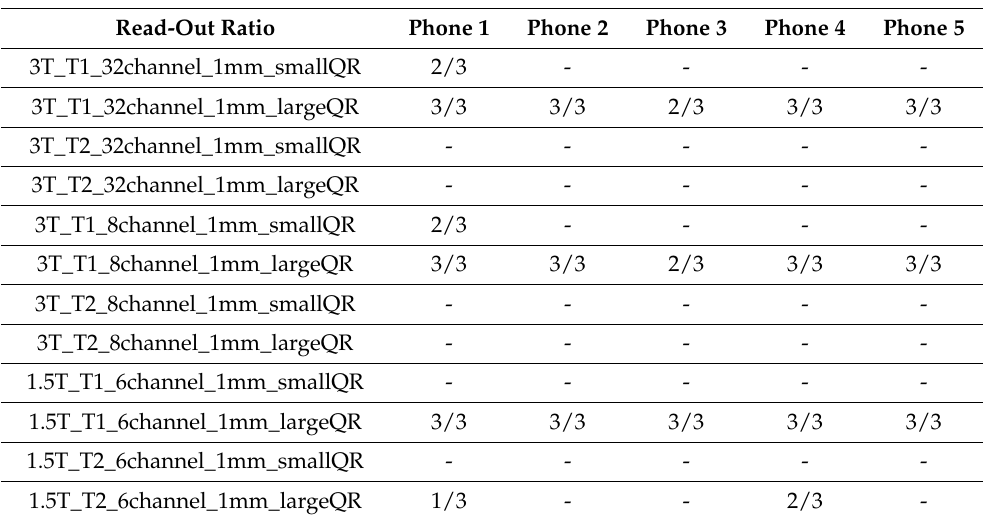
Figure 9. Averaged read-out ratios of the three repeated measurements in the case of the Python program processing. All original and interpolated coronal images of small QR and large QR phantoms were read by the developed Phyton code. Data from the 2 × 2 × 2 mm 3 resolution are not presented due to the lack of successful decoding. Table 7. Read-out results by different smartphones. The middle coronal images of the three con- secutive measurements were used to show the ratio of the successful and total decrypting of the QR code information. Data from the 2 × 2 × 2 mm 3 resolution are not presented due to the lack of successful